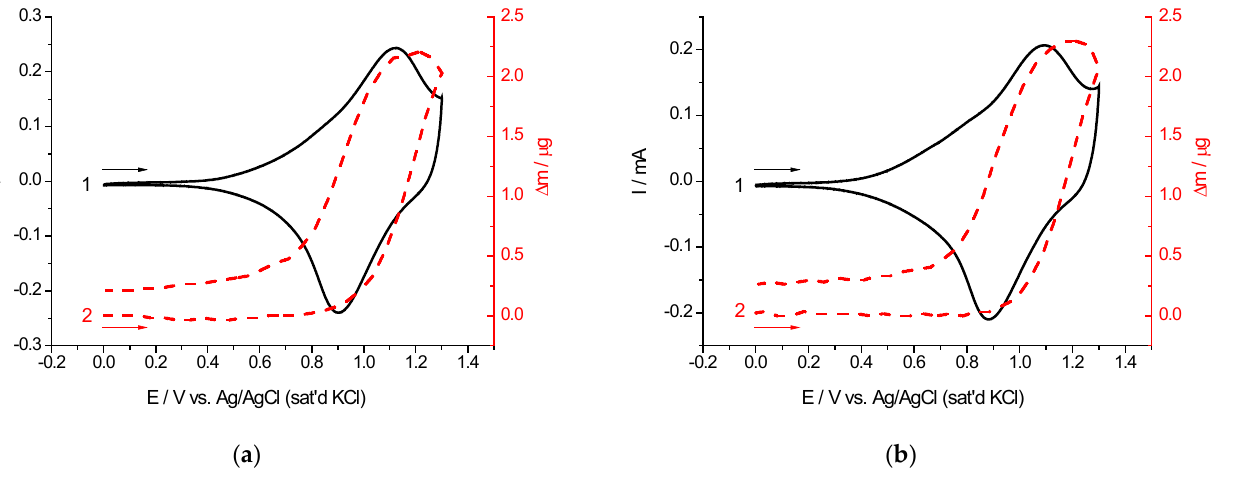
Figure 3. Cyclic voltammograms of a Pt-coated quartz crystal electrode (1.37 cm 2 ) modified with poly[NiSalphen] ( a , black curve 1) or poly[NiSalphen(CH 3 O) 2 ] ( b , black curve 1) at a scan rate of 0.05 V s − 1 in 0.1 M Et 4 NBF 4 /PC and the corresponding electrode mass variation vs. potential during the CV cycle of poly[NiSalphen] ( a , red curve 2) or poly[NiSalphen(CH 3 O) 2 ] ( b , red curve 2).